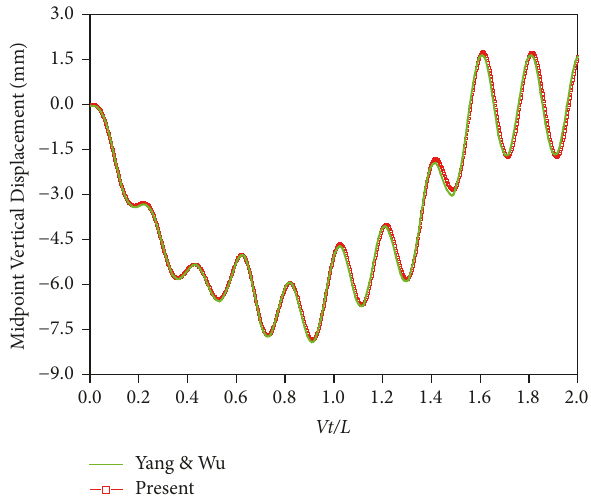
Figure 3: Vertical displacement of midpoint of simply supported beam.